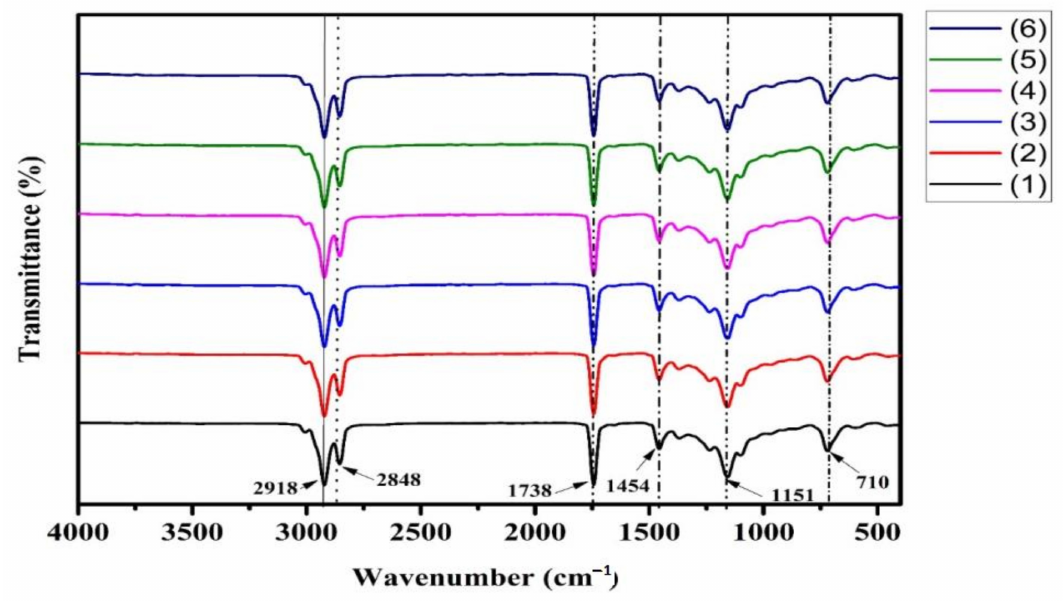
Figure 8. Spectral analysis obtained from FTIR for oils recovered from sesame seeds roasted with different methods: 1: Unroasted, 2: local market roasted, 3: stovetop pan, 4: oven, 5: microwave, and 6: electric frying